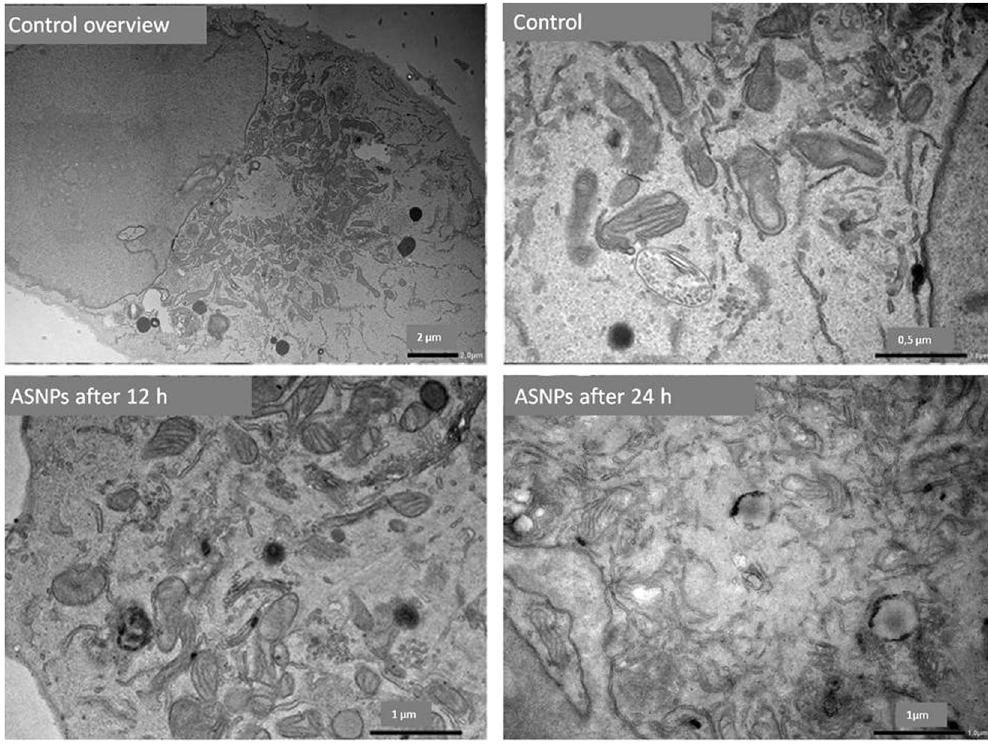
Figure 11. TEM image for internalization of ASNPs across the cell membrane after 12 and 24 hours post treatment.